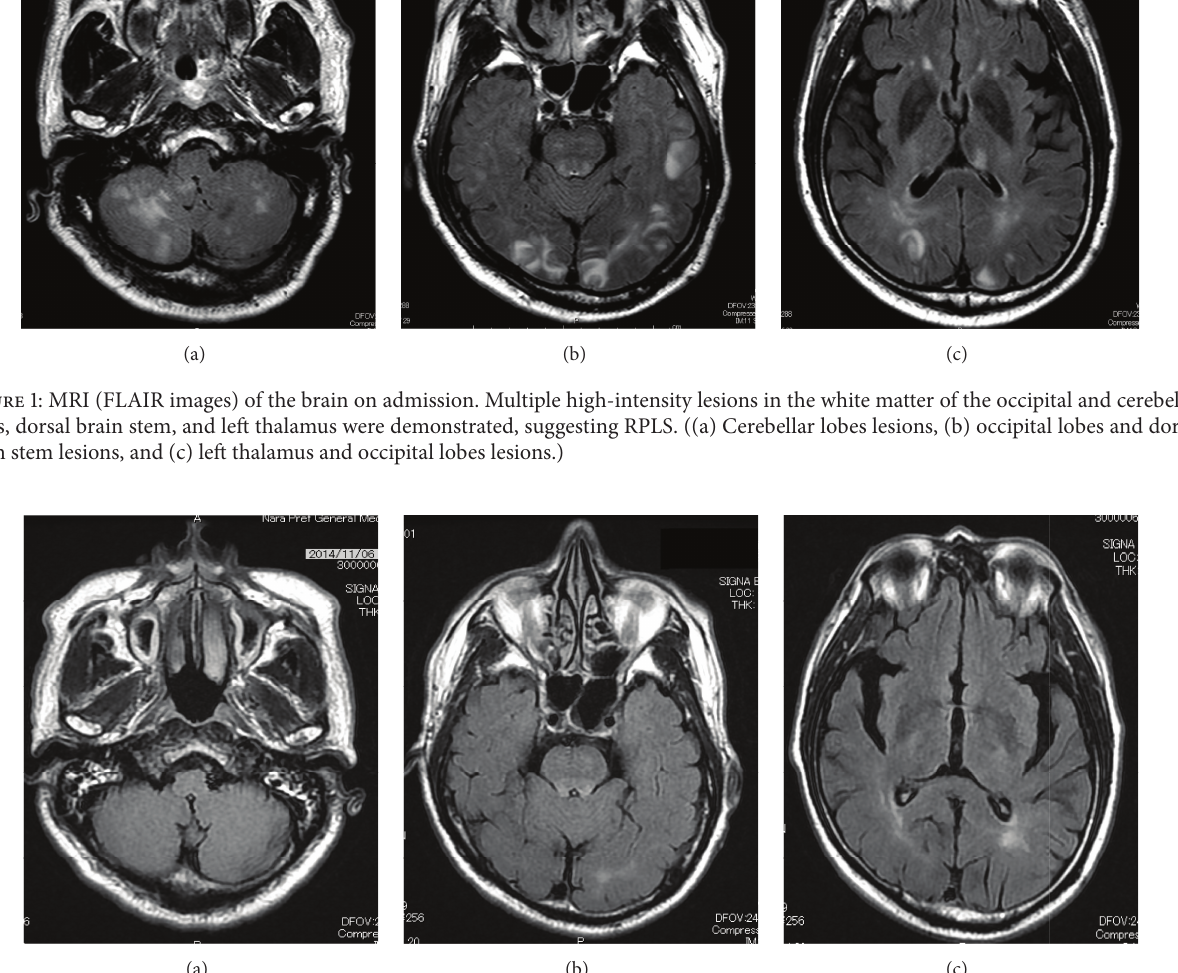
year after its discontinuation because of progressive disease (new metastatic lesions on the left adrenal gland and pancreas head) on enhanced